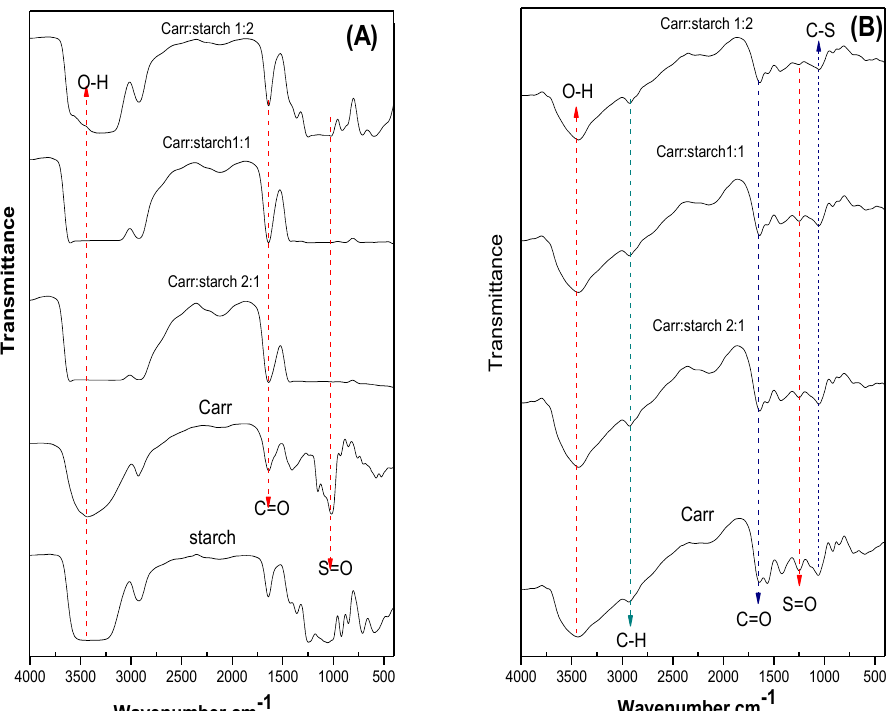
Figure 2. FTIR spectra of Carr, starch, and Carr/starch blend-based membranes before enzymatic enzymatic treatment ( B ). treatment ( A ) and after enzymatic treatment ( B ).